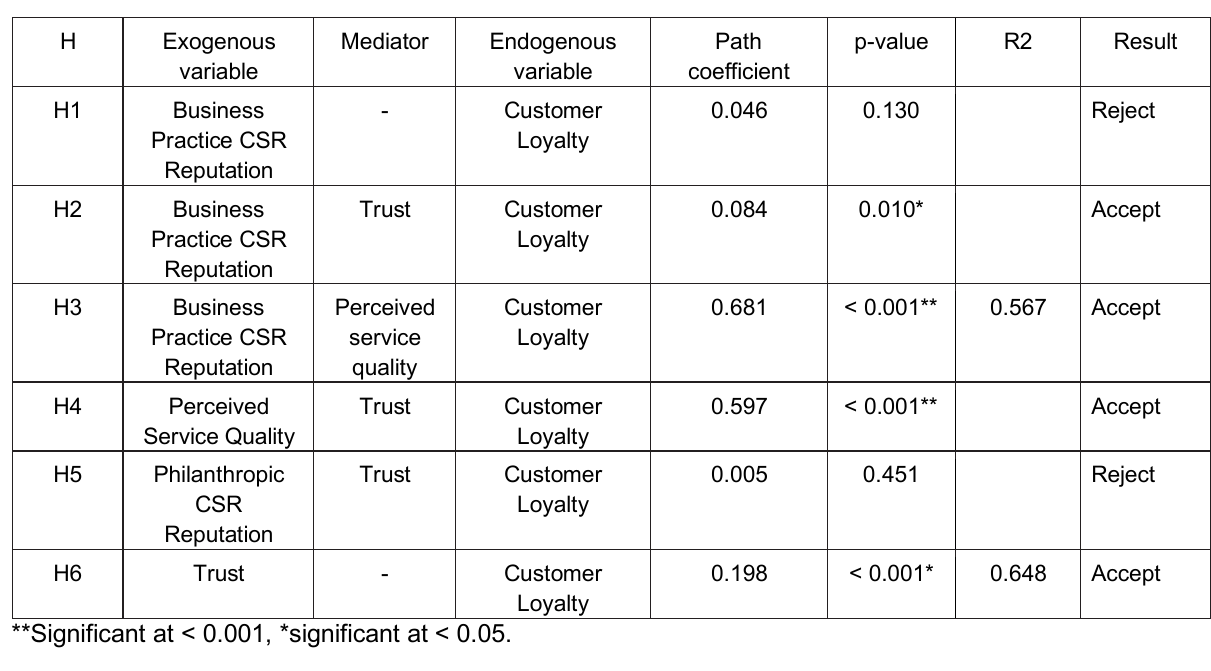
Table 6: Evaluation of path